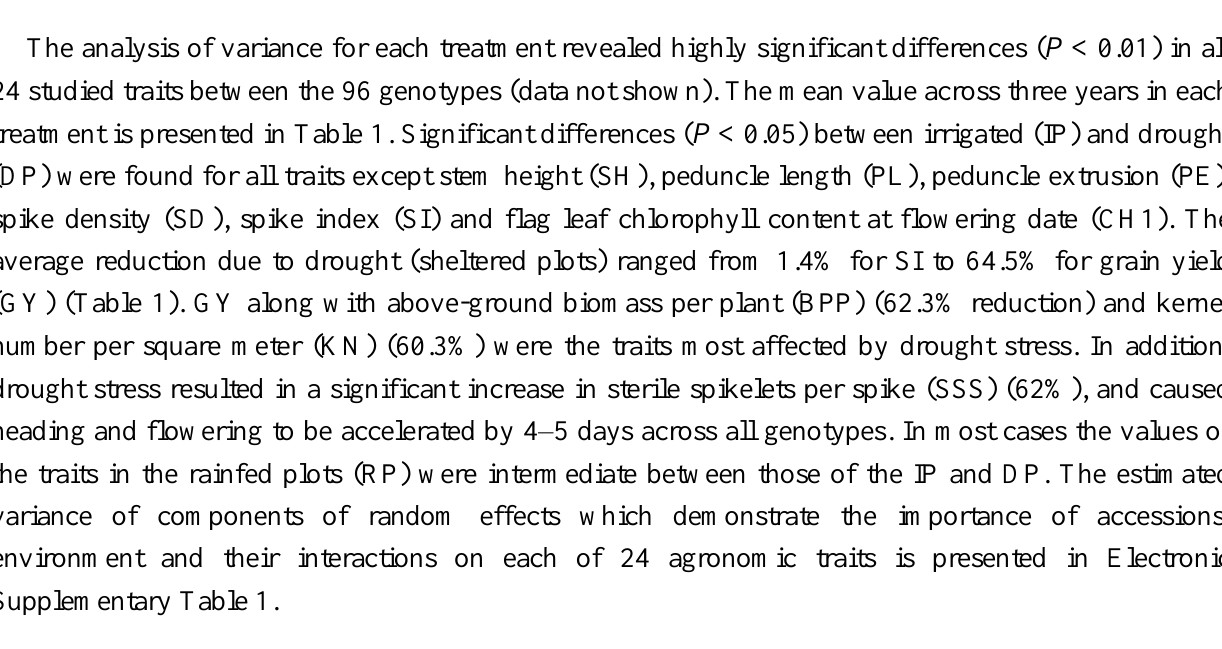
Table 1. Trait means in irrigated (IP), rainfed (RP) and drought (DP) plots (averaged over 3